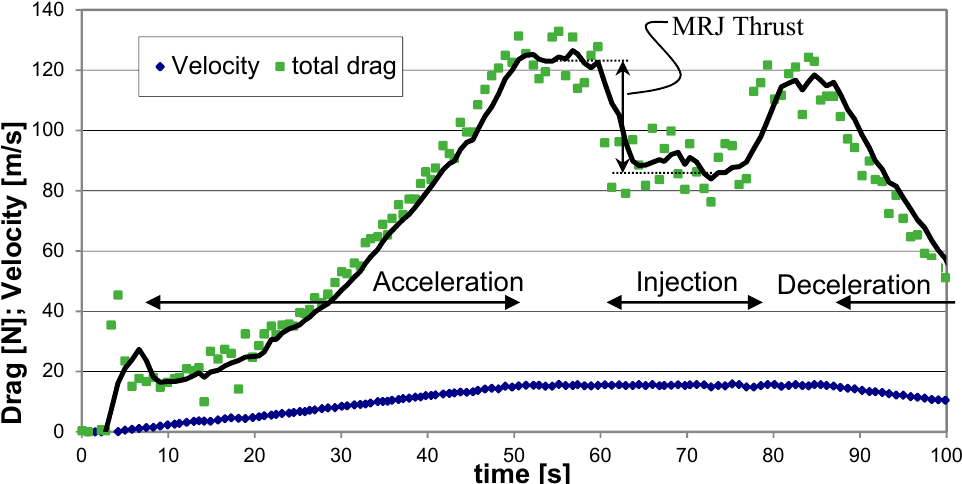
Figure 11. Typical drag and velocity readings during an experimental run showing the thrust resulting from air injection, at a cruise speed of 15 m/s.